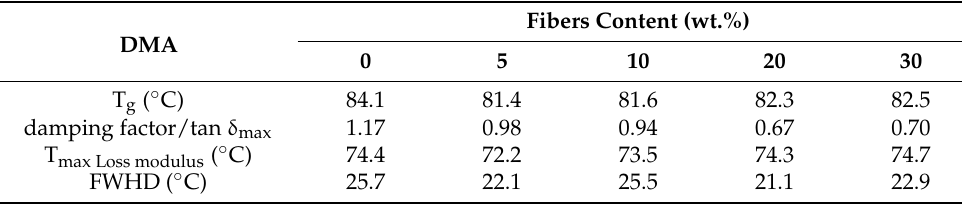
Figure 9. Tangent δ (tan δ) versus temperature for all compositions. Table 4. Data of dynamic mechanical studies (DMA) measurements.